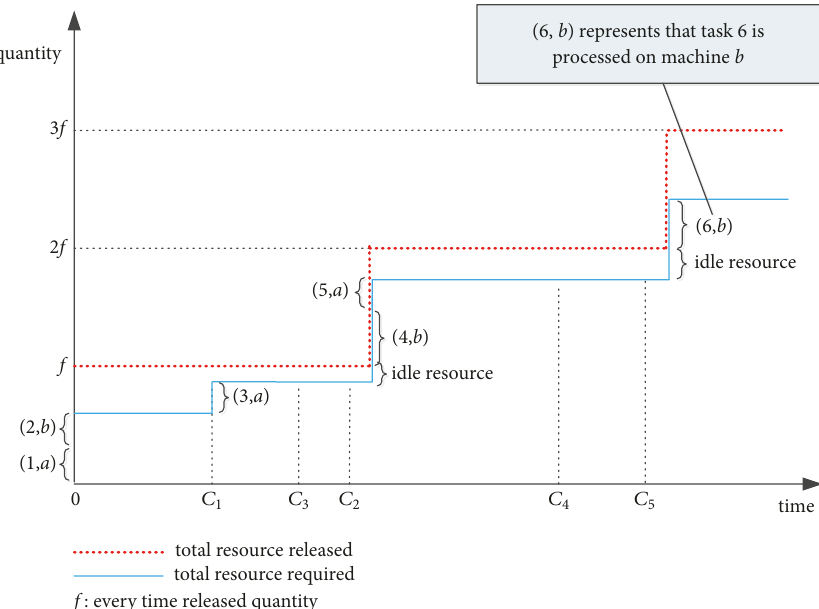
Figure 2: Resource released time constraints in continuous-casting production.